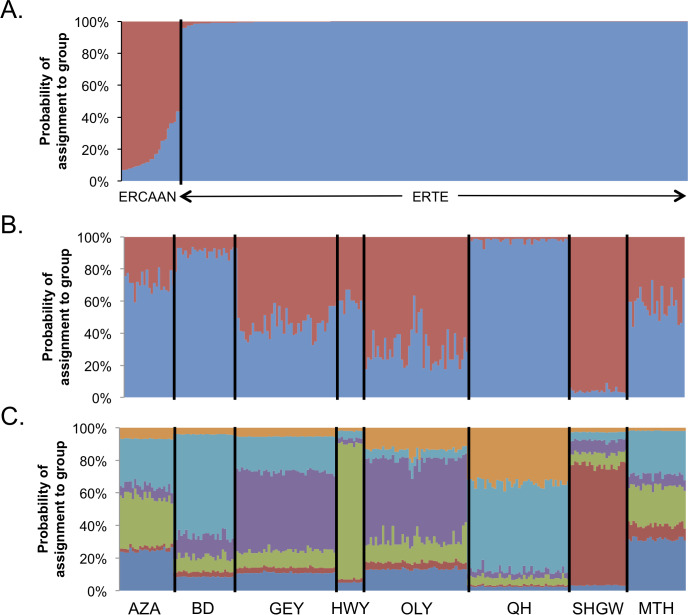
Structure results for ERTE and ERCAAN with various subdivisions.Assignment probabilities for individuals sampled from eight ERTE populations and two ERCAAN populations for the optimal k = 2 (A) and similar analyses for just the ERTE samples for k = 2 (B) and k = 6 (C). Population abbreviations are the same as in Table 1.